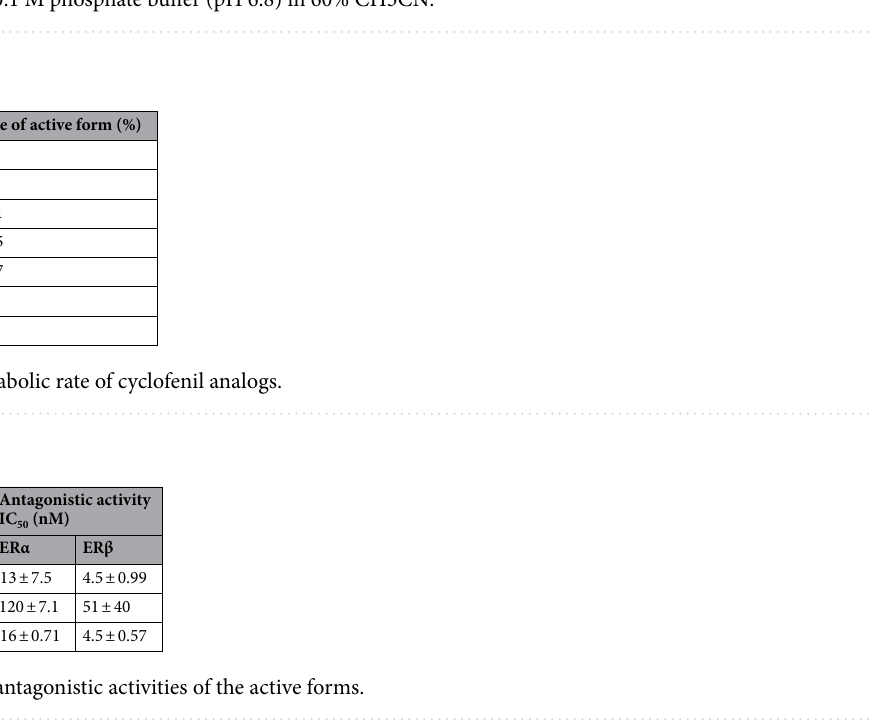
Table 2. retention time of cyclofenil analogs on IAM column. a IAM.PC.DD2 Column, mobile phase consisting of 0.1 M phosphate buffer (pH 6.8) in 60% CH3CN.